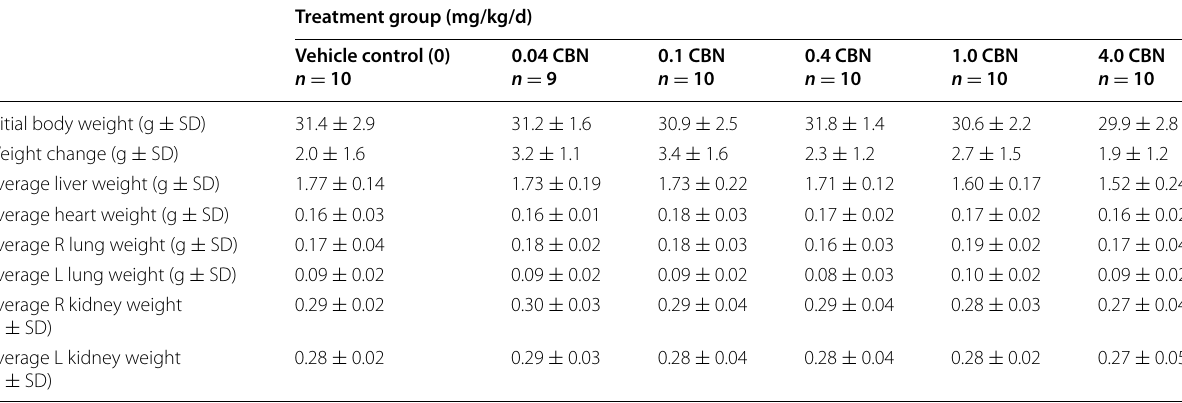
Table 2 Effects of CBNT on body and organ weight in